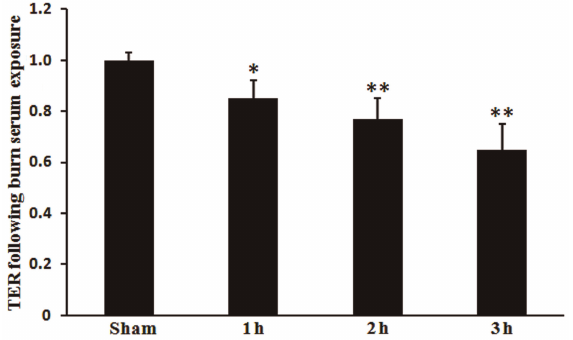
Figure 1. Effect of burn injury on rat lung microvascular endothelial cells (RLMVEC) monolayer permeability. TERs (normalized transendothelial electrical resistance) are shown for each group. RLMVEC monolayers were treated with serum from sham or burn rats 1, 2 or 3 h post-burn. Monolayer permeability increased significantly at each time point in the burn serum- treated cells compared with the sham serum-treated cells. Data are reported as means±SD (n=5 in each group). *P , 0.05, **P , 0.01, compared to the sham group (one-way ANOVA).